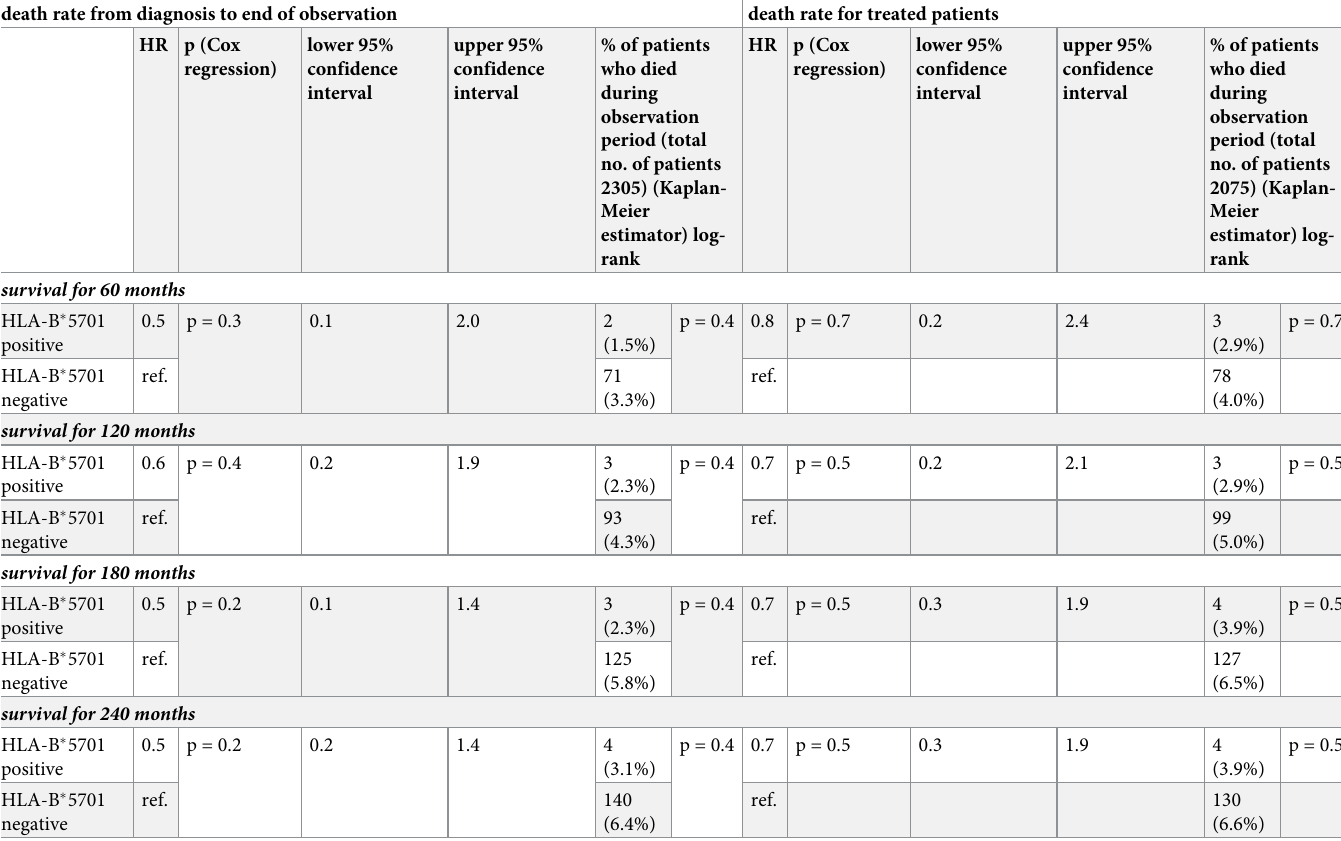
Table 2. Overall survival rate for HLAB5701 positive and negative individuals. death rate from diagnosis to end of